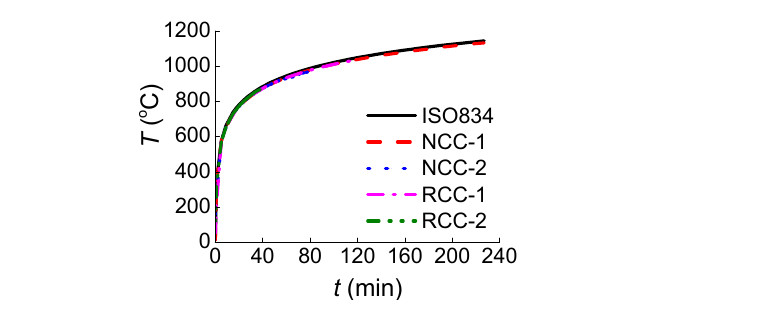
Figure 3. Comparison curves between the actual temperature and ISO834 heating curve.